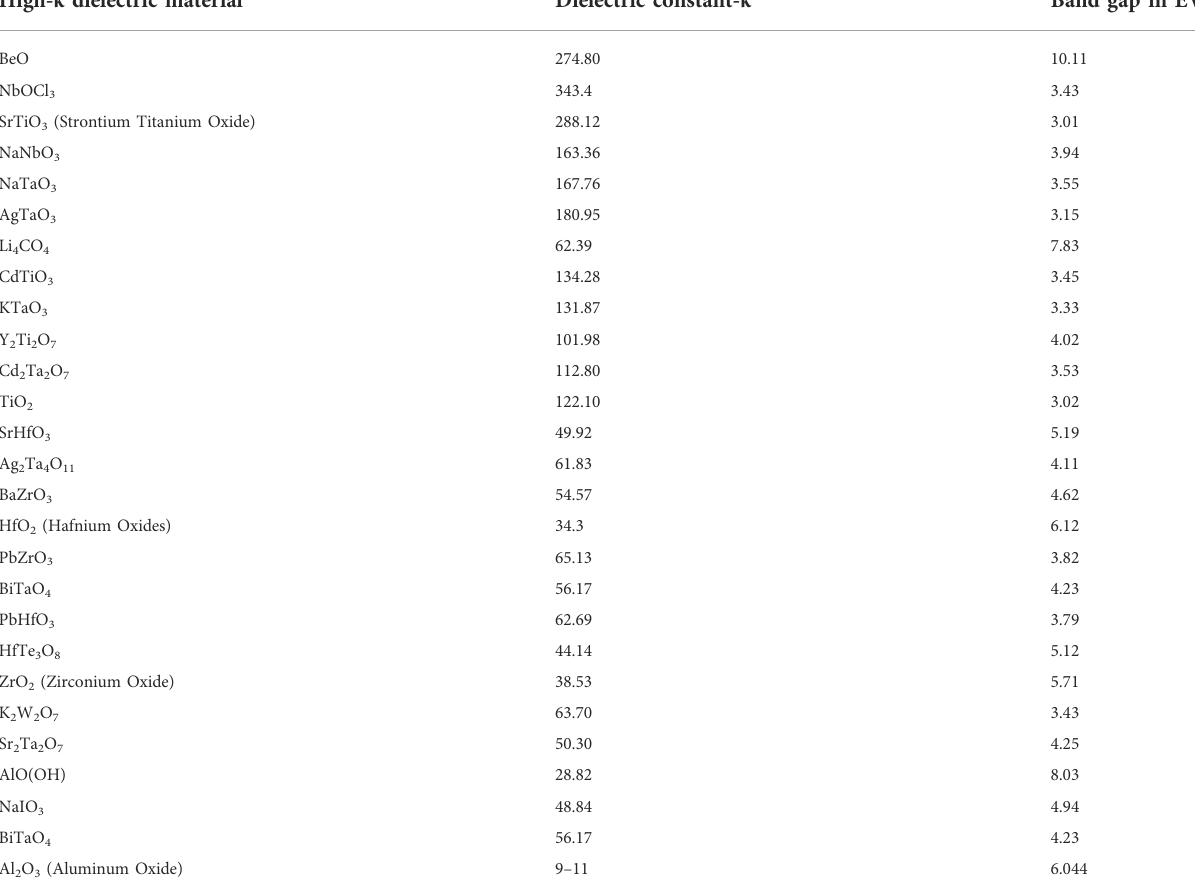
TABLE 1 List of High- κ dielectrics with their dielectric constants and band gap [2]. High- κ dielectric material Dielectric constant- κ